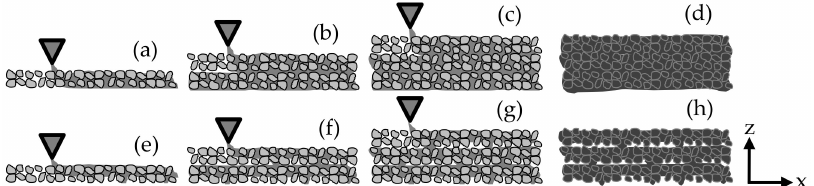
Figure 1. Production process of Selective (Cement) Paste Intrusion (SPI) with complete layer bond- ing/filling of voids ( a – d ) and with incomplete layer bonding/filling of voids ( e – h ) [26]. Due to the supporting function of the unbound particles, almost any overhanging construction with high surface resolution, high strength (up to 78 MPa) and high dura- bility as well as density comparable to ordinary concrete (by filling up a present particle network) [26,33–35] can be created, Figure 2.